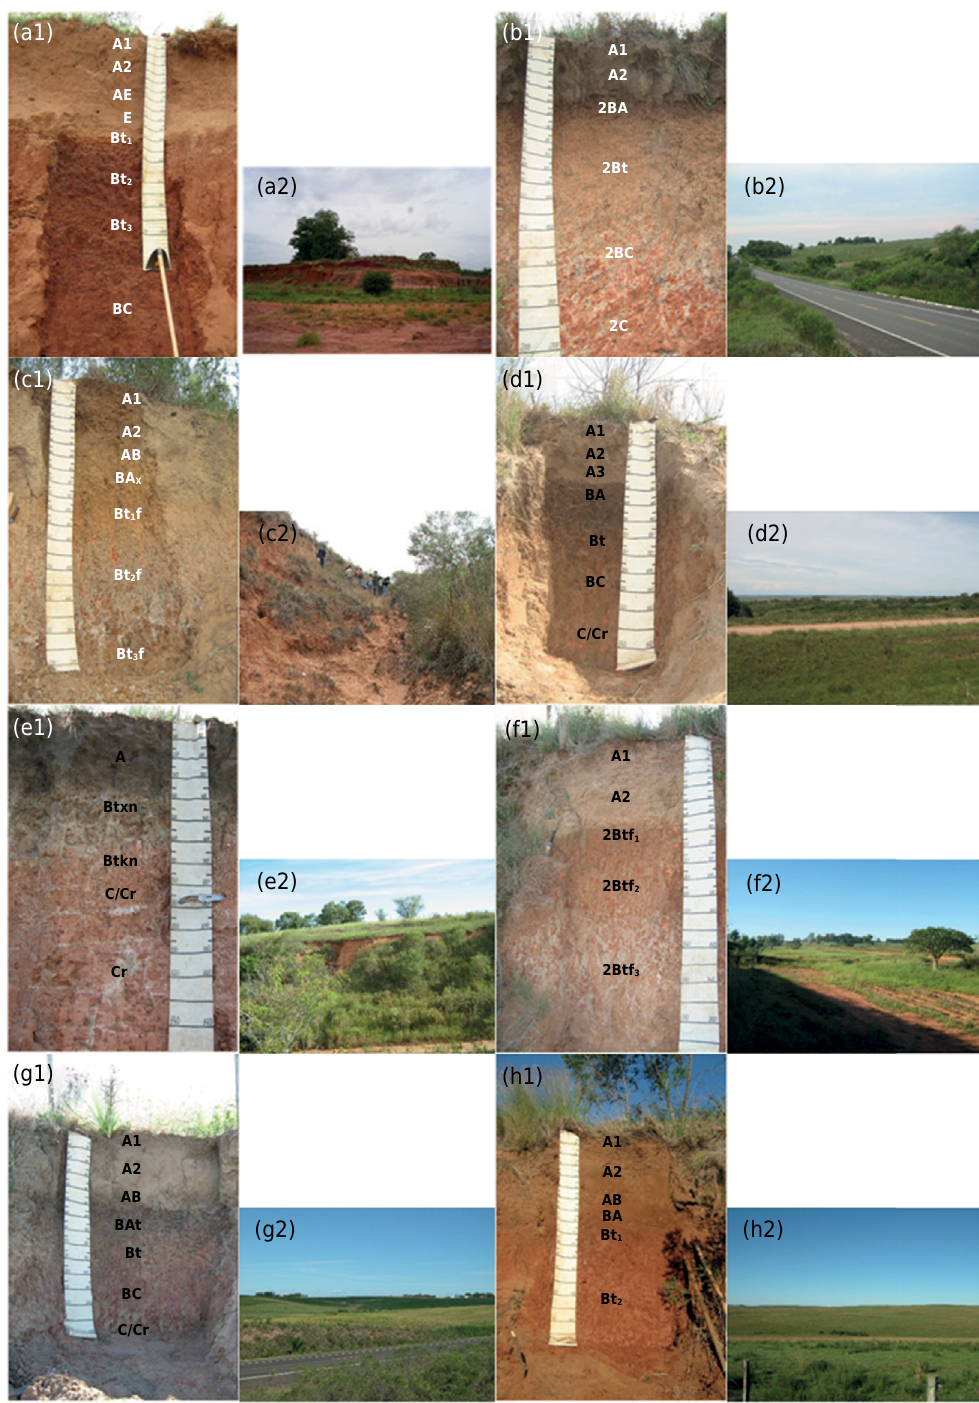
Figure 3. Soil profiles and landscape of occurrence: (a1 and a2) P1T1; (b1 and b2) P2T1; (c1 and c2) P3T1; (d1 and d2) P1T2; (e1 and e2) P2T2; (f1 and f2) P3T2; (g1 and g2) P1T4; and (h1 and h2)